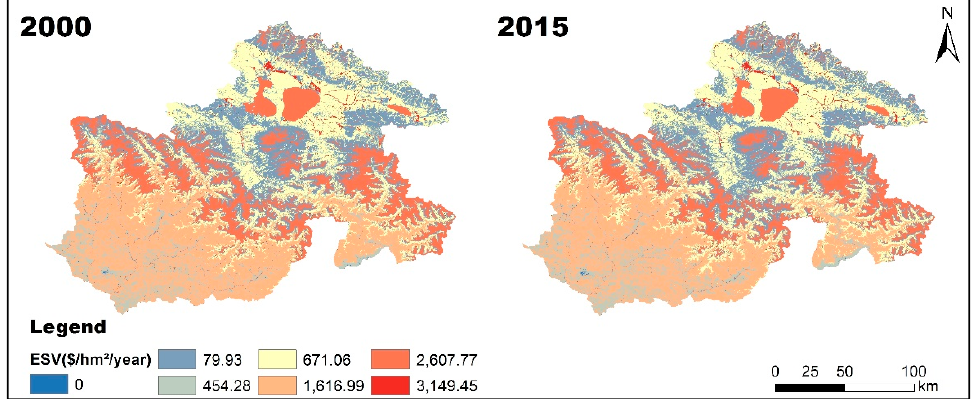
Figure 5. The distribution of ESVs in the KSL in 2000 and